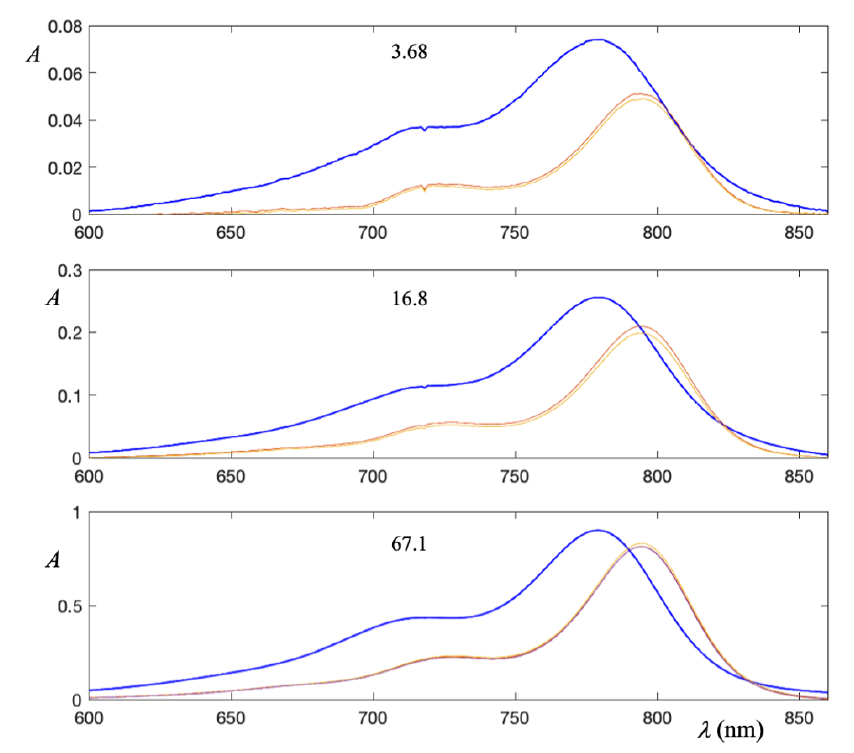
Figure 4. Absorption spectra of ICG in ternary systems LAP-ICG-water. In the presence of the clay absorption peaks are shifted towards right of about 13 nm (red shift). The number in the each plot is the ICG concentration expressed in µ